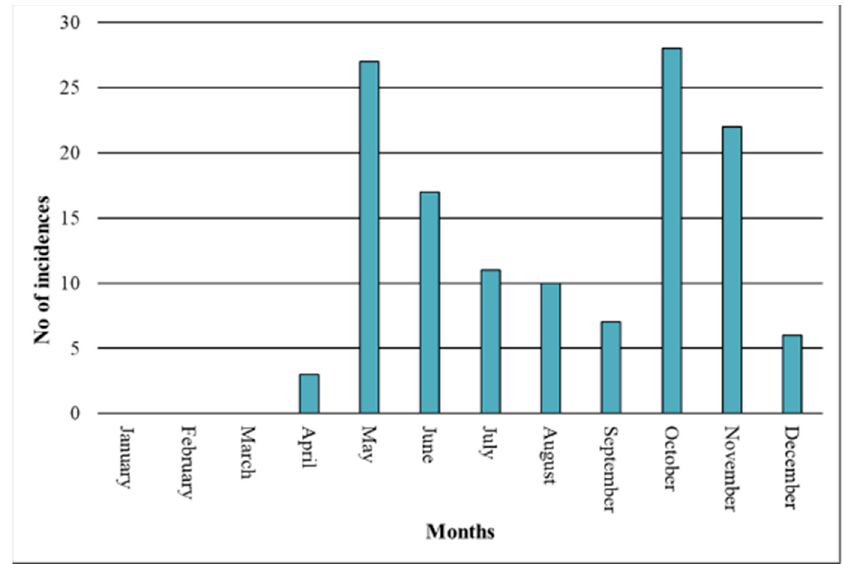
Figure 3. Recurrence interval of cyclones making landfall in the study area.